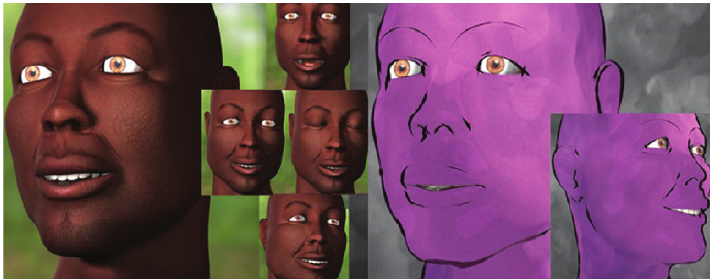
Figure 9: TASIT social sequences using expression units 3D rendered realistically (left) and in a drawing style